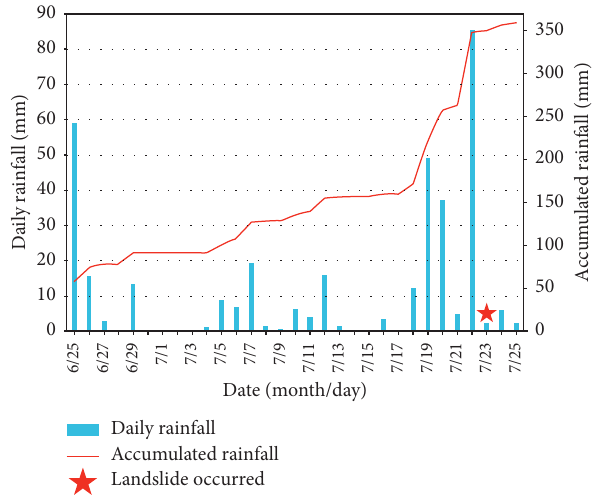
Figure 4: Rainfall preceding the Shuncheng landslide.